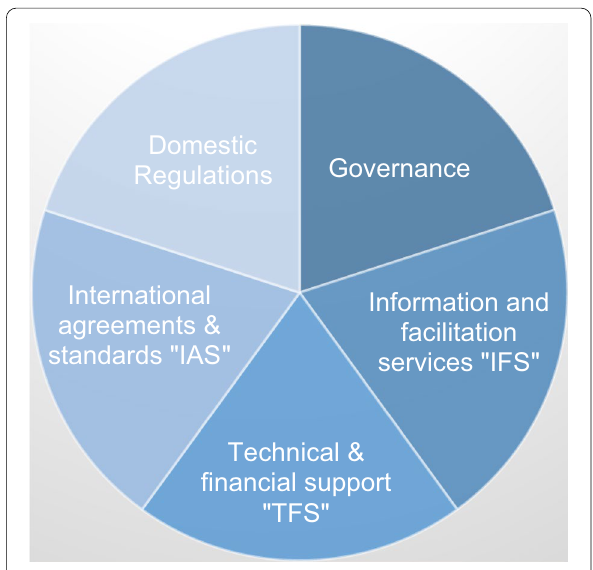
Fig. 1 Framework for policies for FDI qualities. Source : [36], p.